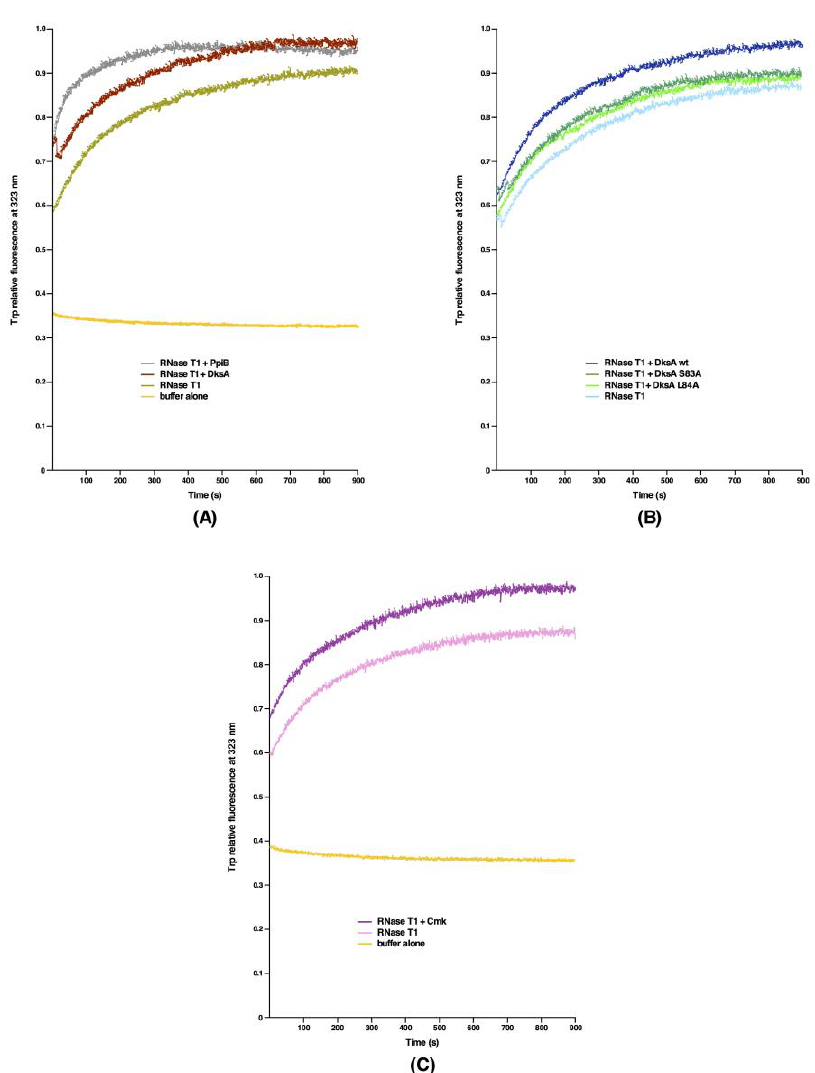
Figure 9. Catalysis of PPIase-dependent refolding of RNase T1. (A) The increase in fluorescence at 320 nm is depicted as a function of time of refolding of RNase T1 in the presence of DksA and PpiB. (B) Measurement of refolding of RNase T1 in the presence of wild-type DksA and different DksA mutants. (C) Refolding of RNase T1 catalyzed by the addition of Cmk as measured by the increase in fluorescence at 320 nm. Reaction when buffer alone is added is depicted in panels A and C.